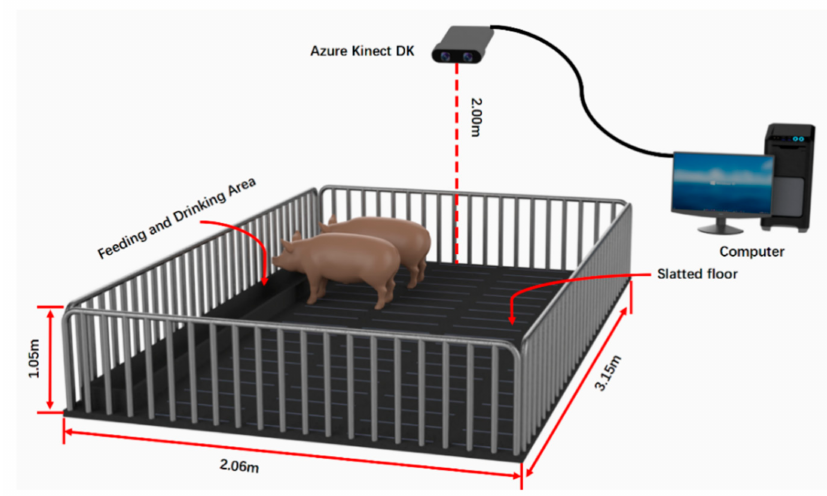
Figure 1. Data acquisition